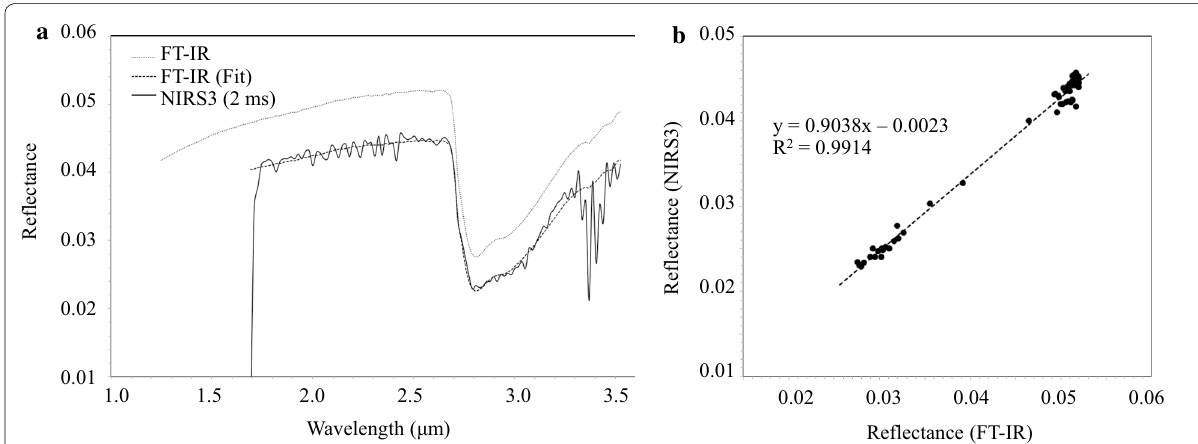
Fig. 2 Fitting process of FT-IR and NIRS3 spectra of Murray meteorite sample. a NIRS3, FT-IR, and fitted FT-IR spectra of Murray. a Relationship between the reflectance values by FT-IR and NIRS3 over the range of 1.96–3.03 μm in wavelength. Integration time of the NIRS3 spectrum is 2.0 ms. The FT-IR spectrum is fitted to NIRS3 spectrum using the correlation line plotted as a broken line in